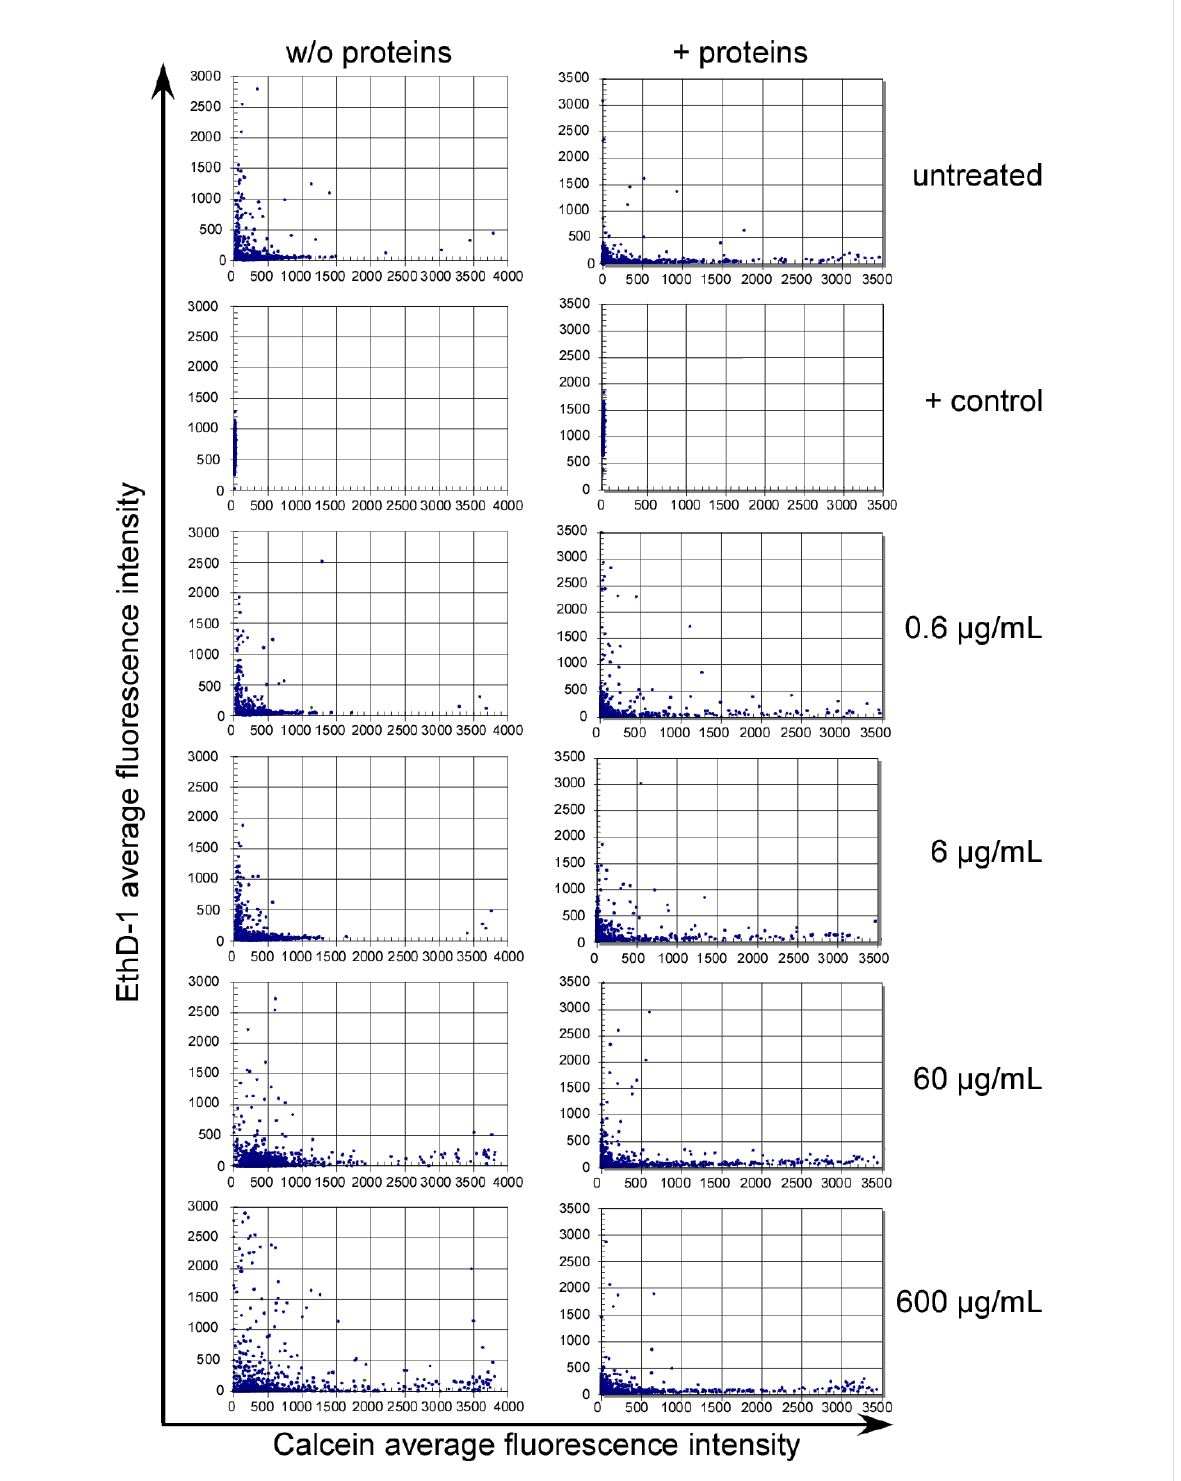
Figure 4: Automated microscopy to analyze the impact of exposure to ASP30 on the cell viability. Caco-2 cells were exposed in DMEM to the indi- cated ASP30 concentrations for 4 h in the absence (w/o protein; left panel) or presence (+-proteins; right panel) of 10% FCS, washed with buffer A, and the vitality was evaluated by using the two-color fluorescence assay. Intensity of calcein (living cells; green) and ethidium homodimer-1 (dead cells; red) signal was monitored using the Cellomics ArrayScan ® VTI. A minimum of 500 cells were analyzed per well, and each treatment was done in triplicate. As a positive control, cells were treated with methanol (+ control), resulting in 100 % damaged